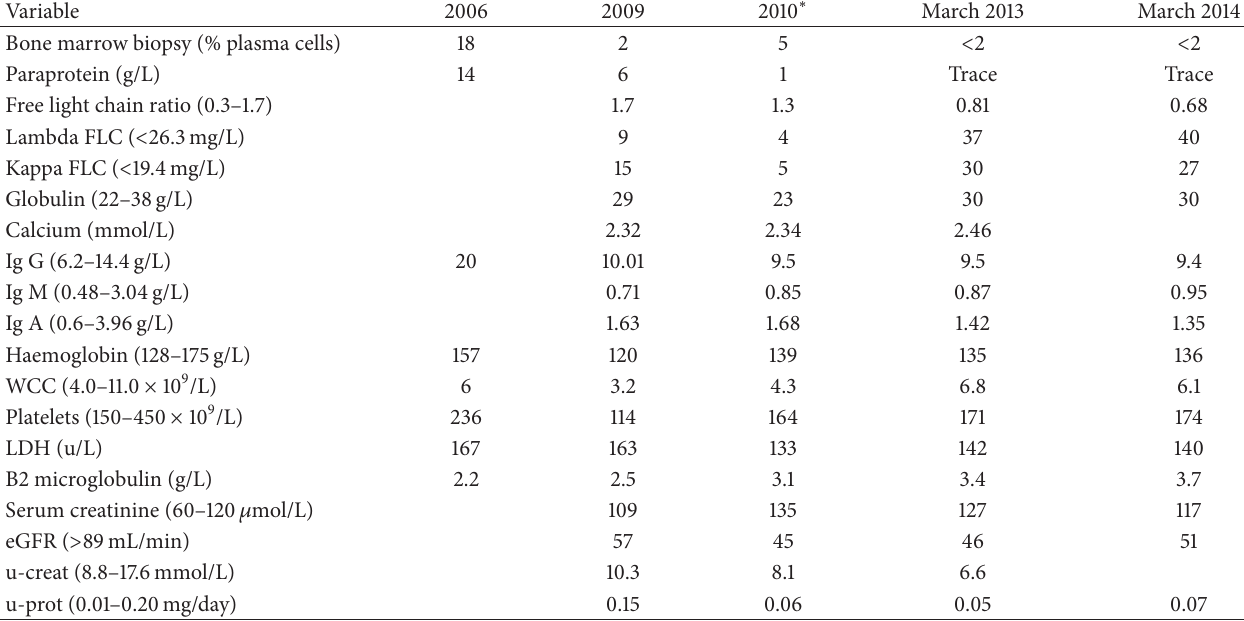
Table 1: Haematological and biochemical data performed at first visit (February 2006) and at 3 months (2009) after commencing curcumin therapy and thereafter annually